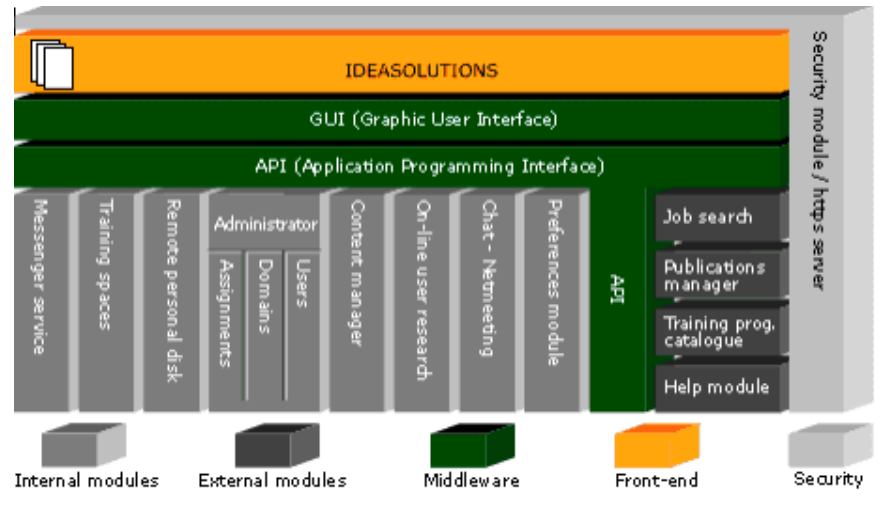
Figure 2. Modular scheme of IDEASolutionsTM